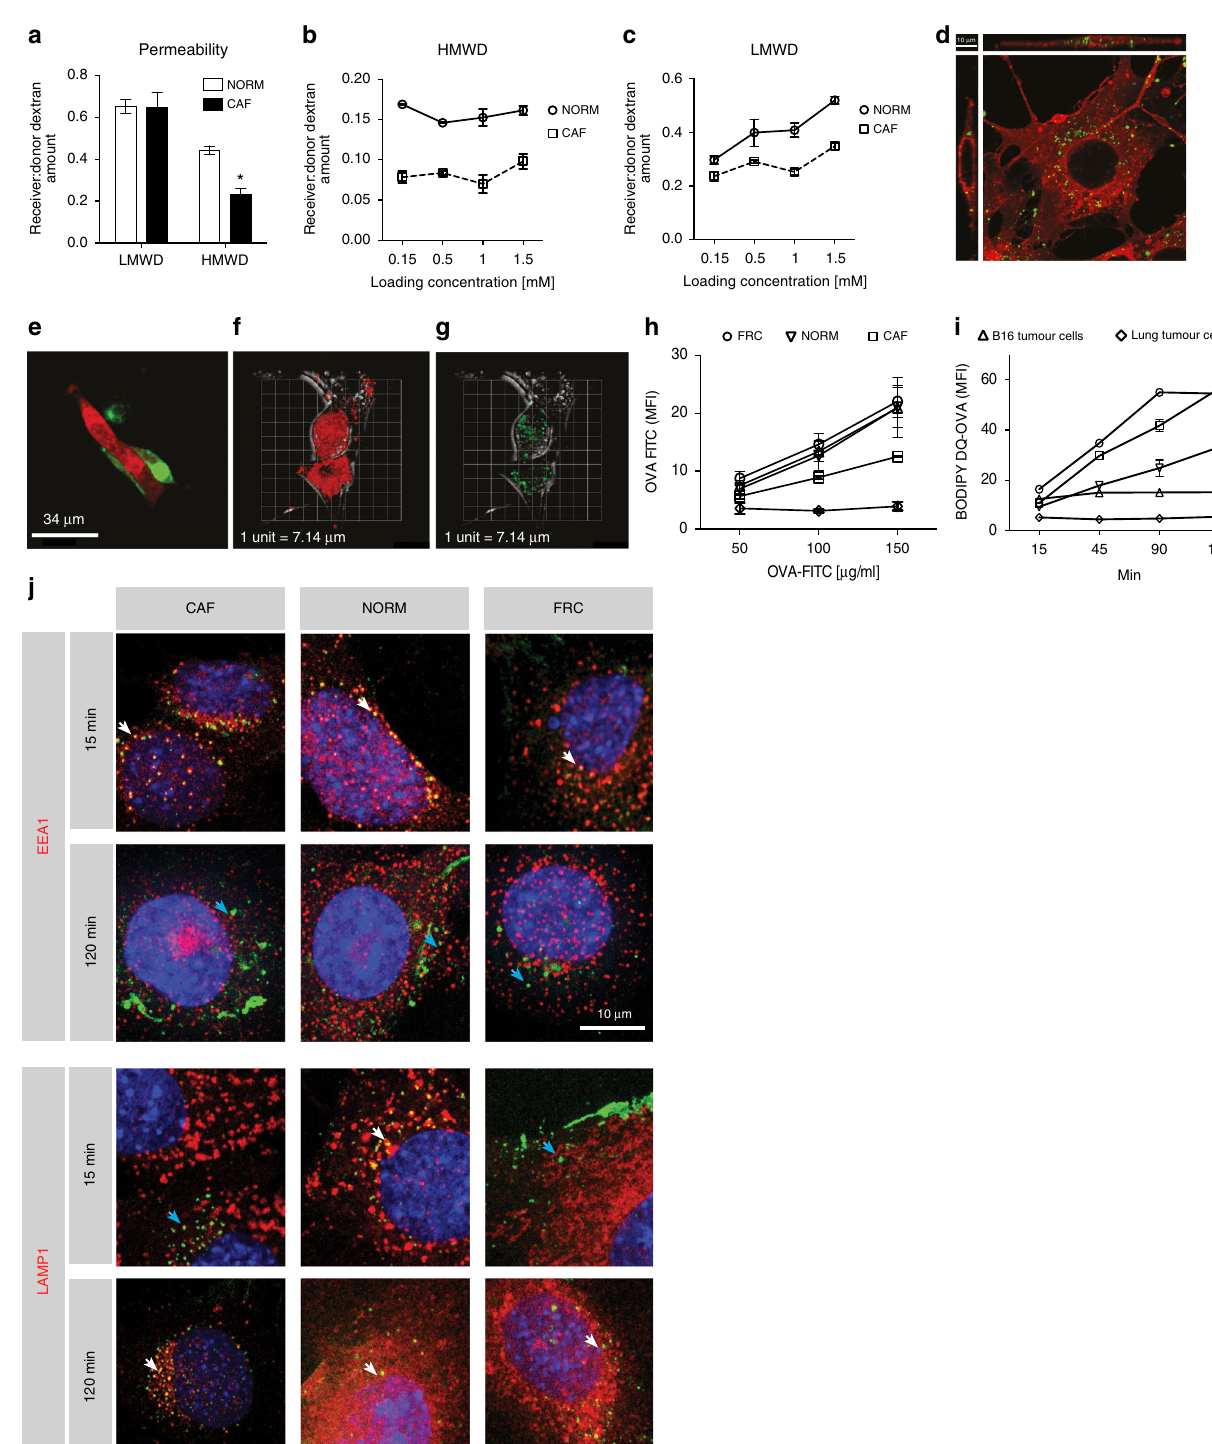
Fig. 1 Cancer associated fi broblasts engulf and proteolytically process cellular debris and antigen. a Relative permeability of low-molecular weight dextran (LMWD) and high-molecular weight dextran (HMWD) across monolayers of normal (NORM, white bars) or cancer-associated fi broblasts (CAF, black bars). b , c Apparent permeability across NORM and CAF monolayers of increasing HMWD ( b ) and LMWD concentrations ( c ). d Representative confocal micrograph including z -plane of HMWD (green) within CAFs (red, Cell Mask). Scale bar, 10 μ m. e Representative confocal snapshot of CAF (red) interacting with dead and dying tumour cells (green). Twenty-four hours after debris engulfment showing CAF (red, f ), and intracellular tumour cell debris (green, g ). h Uptake of FITC-labelled OVA by fi broblasts and tumour cells. i Processing of DQ-OVA by fi broblasts and tumour cells. j Representative micrographs of endosomal compartments (red) showing early endosomes (EEA1) and lysosomes (LAMP1) at 15 and 120 min post ovalbumin pulse (green). Areas of co-localisation (white arrows) and ovalbumin not within labelled compartments (blue arrows) are indicated in each image. Scale bar: 10 μ m. Data shown as mean ± SEM. a * P < 0.05 vs. NORM fi broblasts (two-tailed unpaired Student ’ s t -test). h , i **** P < 0.0001 (two-way ANOVA with Tukey post hoc analysis vs. CAFs). NS, not signi fi cant. Assays performed in duplicate from three ( h ) or two independent experiments ( i